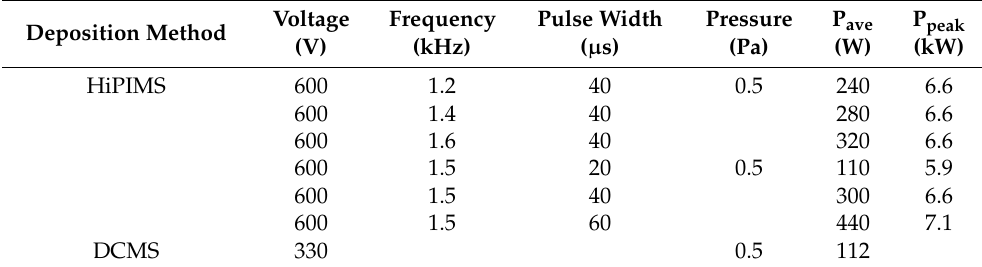
Table 1. High-power impulse magnetron sputtering (HiPIMS) and dc magnetron sputtering (DCMS) deposition parameters for Cr 2 AlC coatings on TiBw/Ti64